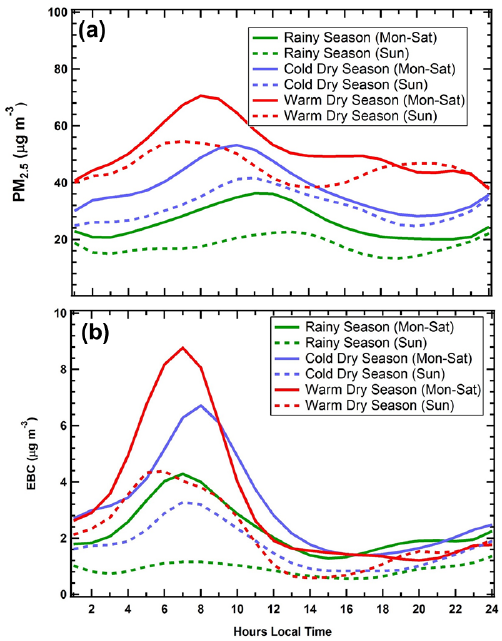
Figure 9. As in Fig. 8, the average hourly (a) PM 2 . 5 mass and (b) equivalent black carbon concentrations are shown, differentiated by seasons and day of the